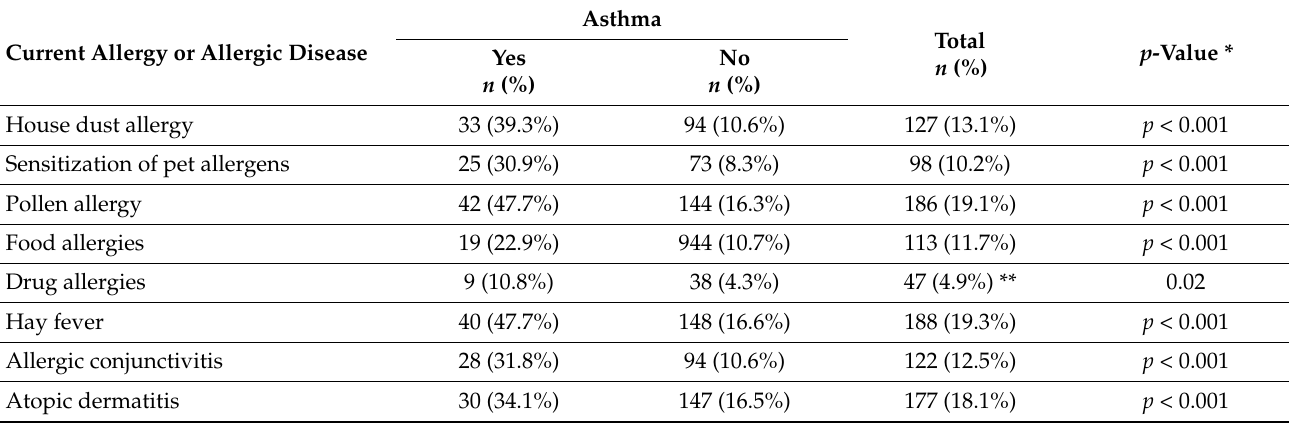
Table 4. Allergies and allergic reactions and the diagnosis of